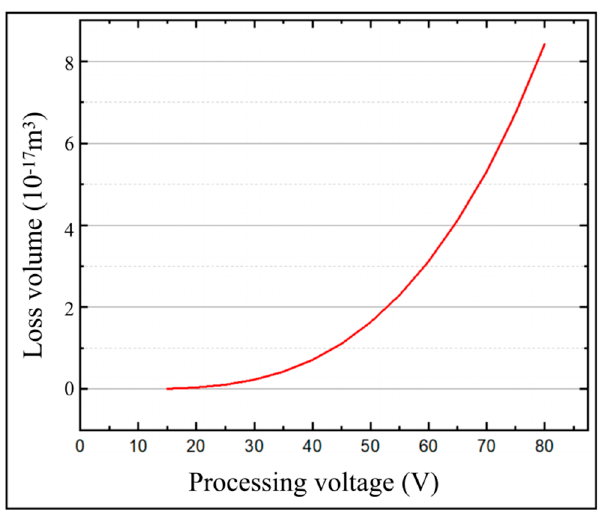
Figure 11. Micro-bit wear volume ( V m ) under different machining voltage.